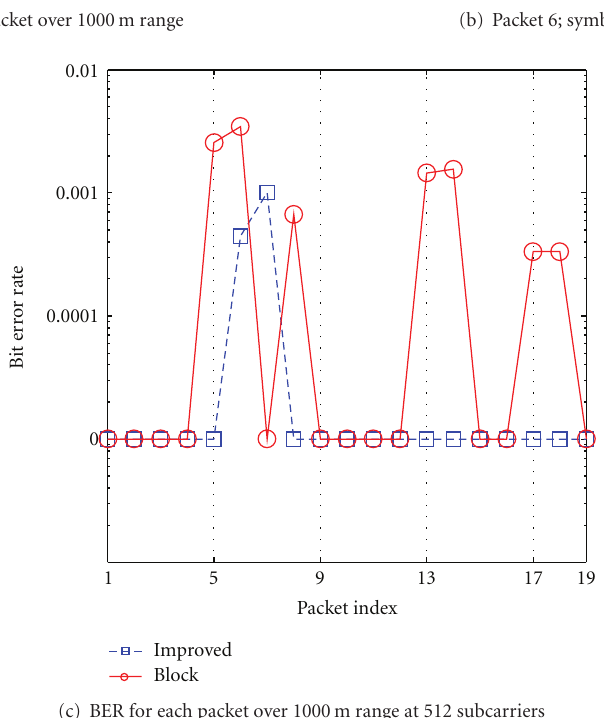
Figure 14: Performance of the improved proposed